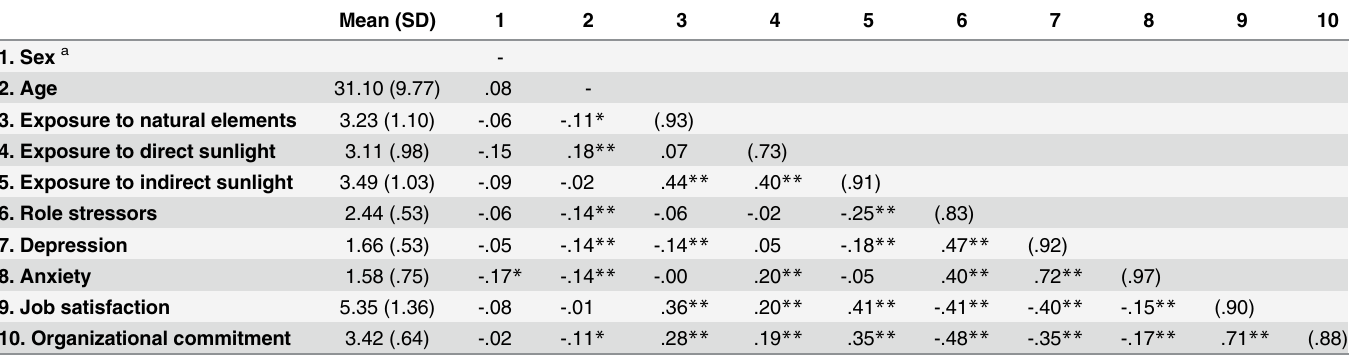
Table 1. Descriptive statistics and correlations among study variables.